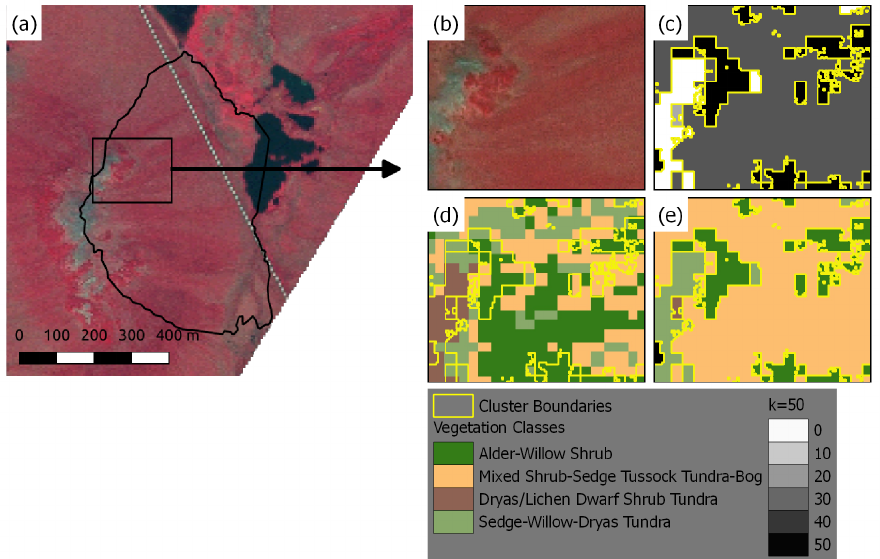
Figure 4. ( a ) Example graphic of the UCVM method over the Kougarok watershed, with a zoomed in view of a specific region of the SPOT-5 false color image ( b ). ( c ) Clustering applied to the input remote sensing variables, with the four clusters (white, black, light gray, and dark gray) outlined in yellow. ( d ) Overlap of the clusters to the AKEVT map and ( e ) reclassed clusters based on the GOF